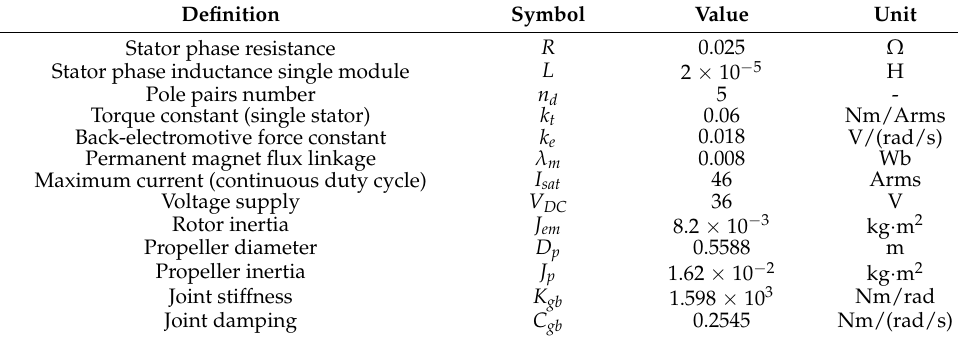
Table A1. FEPS model